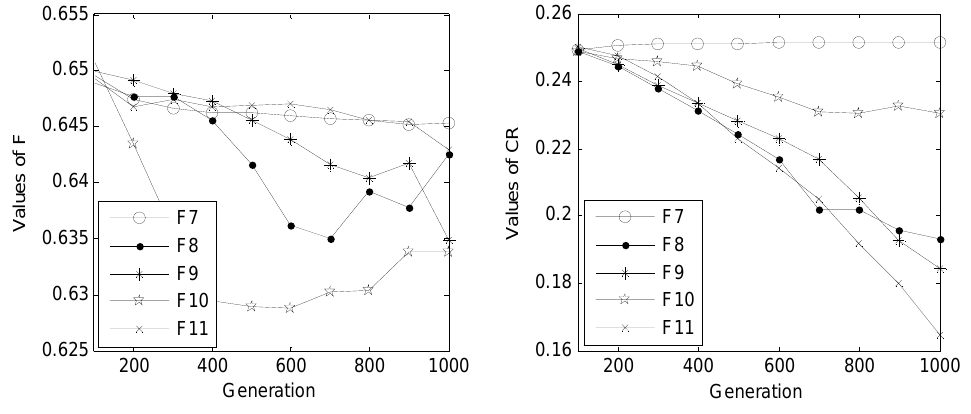
Fig. 4 Variant tendency of F Fig. 5. Variant tendency of